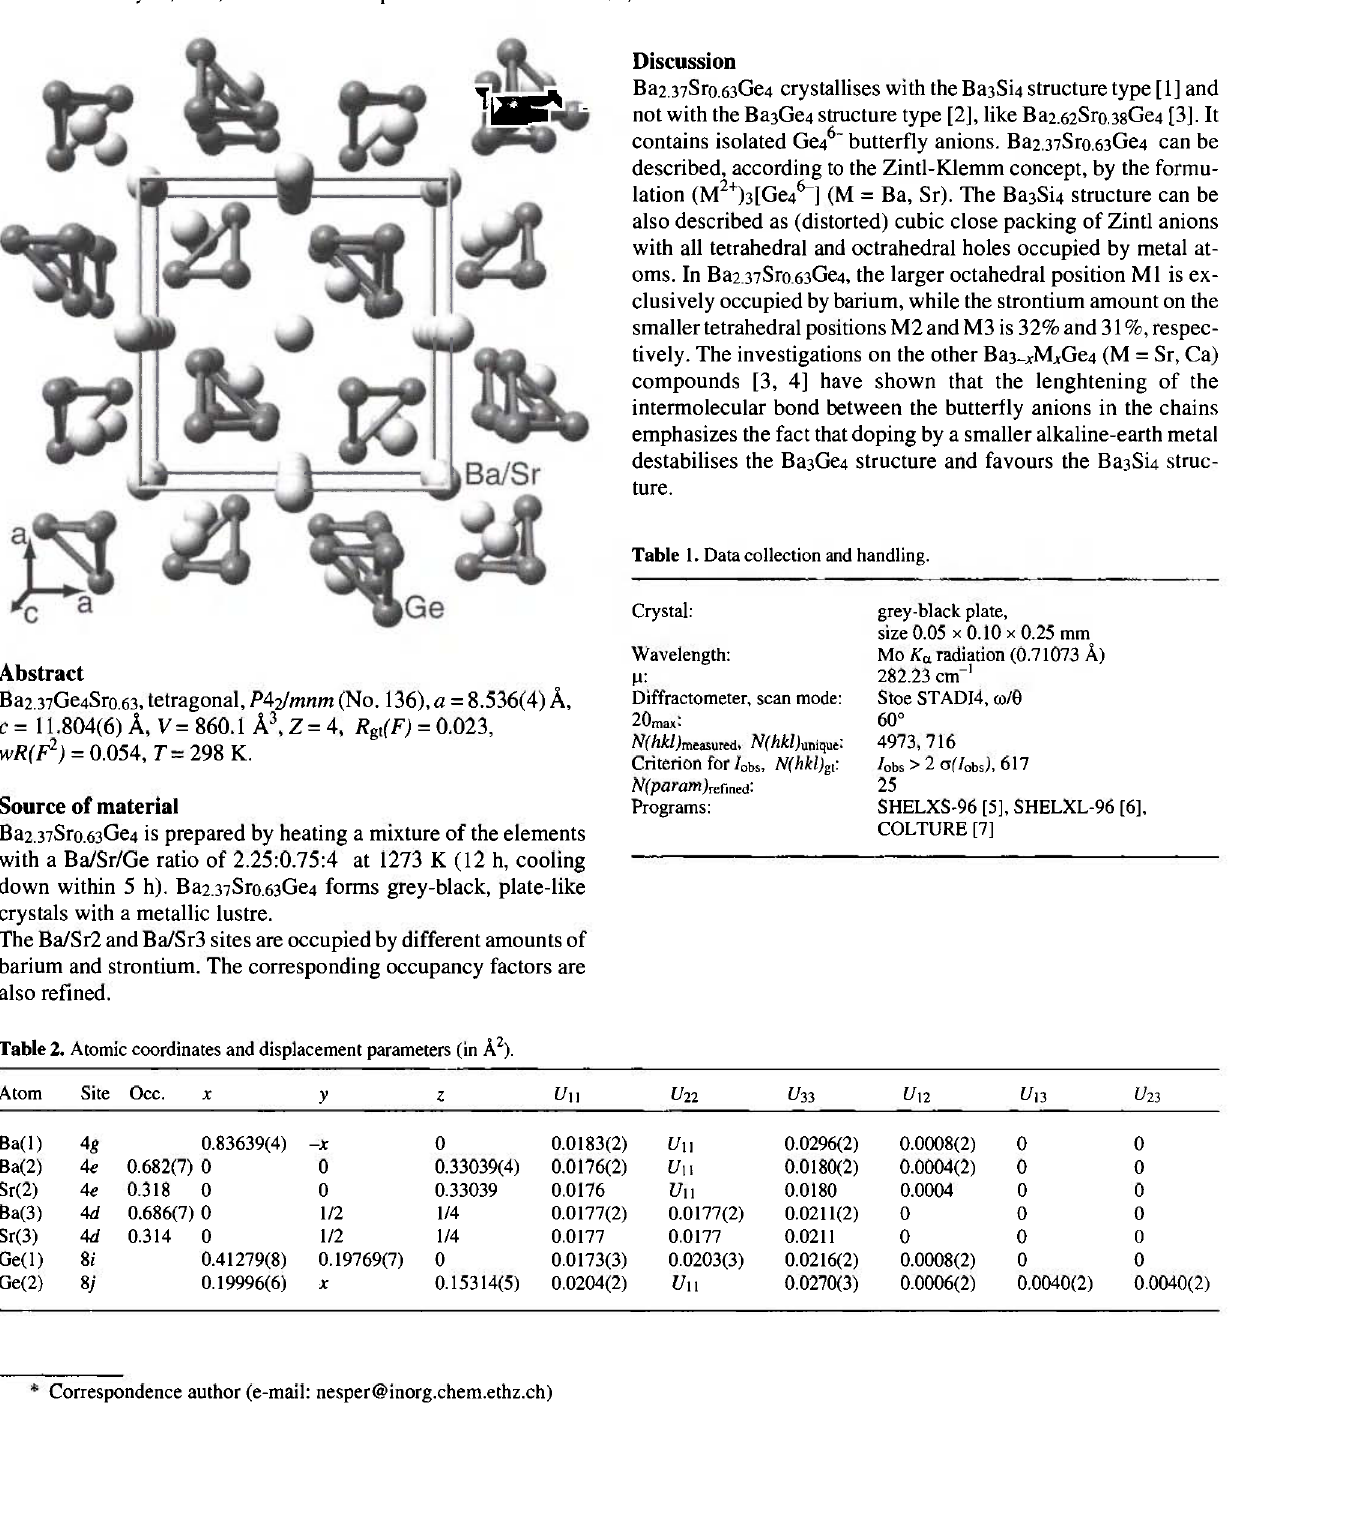
Discussion Ba2.37Sro.63Ge4 crystallises with the Ba3Si4 structure type [ 1 ] and